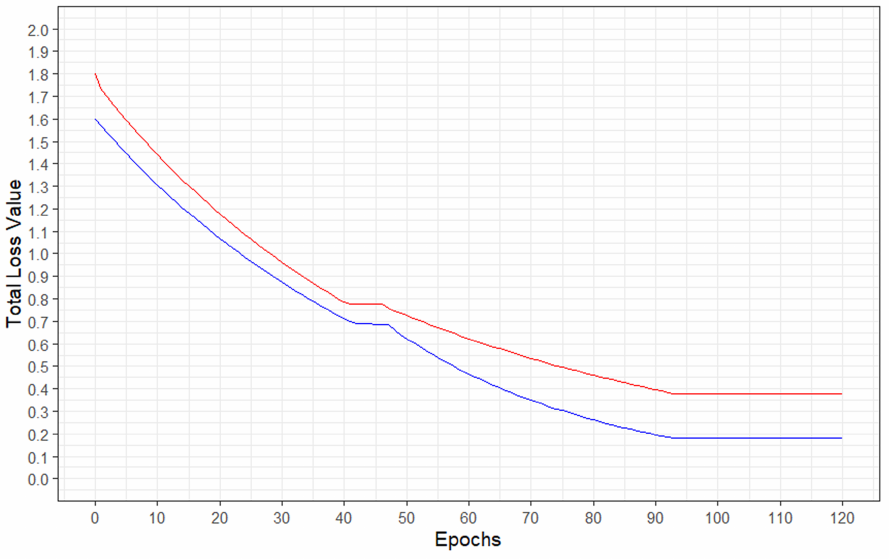
Figure 7. Evolution of training total loss values (blue line) and validation total loss values (red line) per